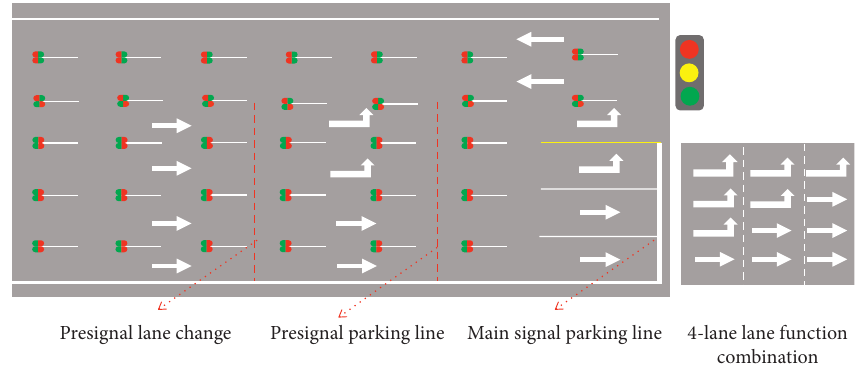
Figure 5: Illustration of the four-entrance-lane configuration.